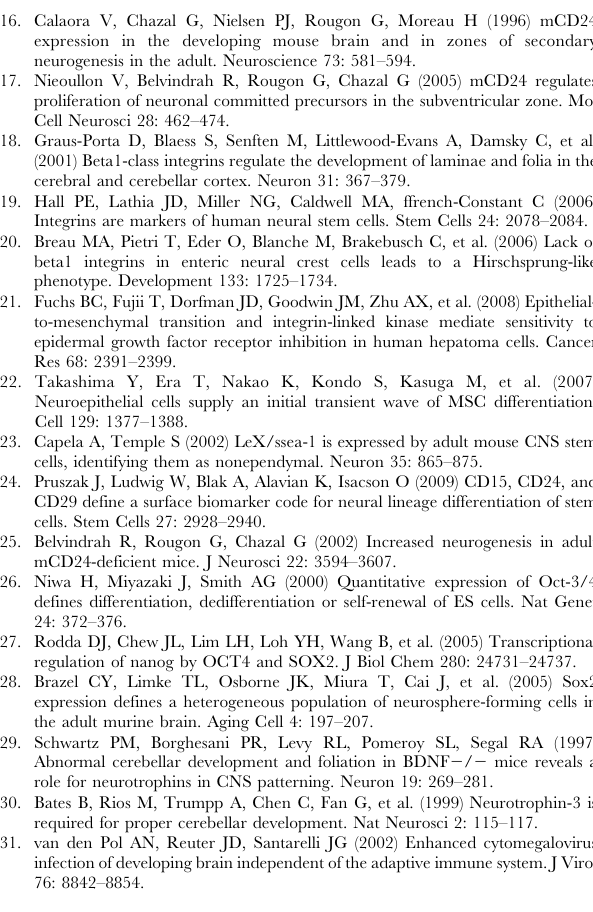
Figure S3 Experimental model simulates congenital cytomega- lovirus infection. Embryos from timed breeders were collected at ED14.5 and brains were dissected out to prepare single cell suspension. Cells were also prepared from brains harvested from 7 d old neonates. Cells were surface stained for CD24 and also for intracellular nestin. Representative dotplot and histogram showing ratios of CD24(hi) cells and percent of maximum cells expressing nestin from both A . ED14.5 and B . P7 brains are shown. No significant difference in the expression levels of CD24 and nestin was observed between the groups analyzed. Data are derived from two independent experiments, n= 3–5 embryos/neonates.